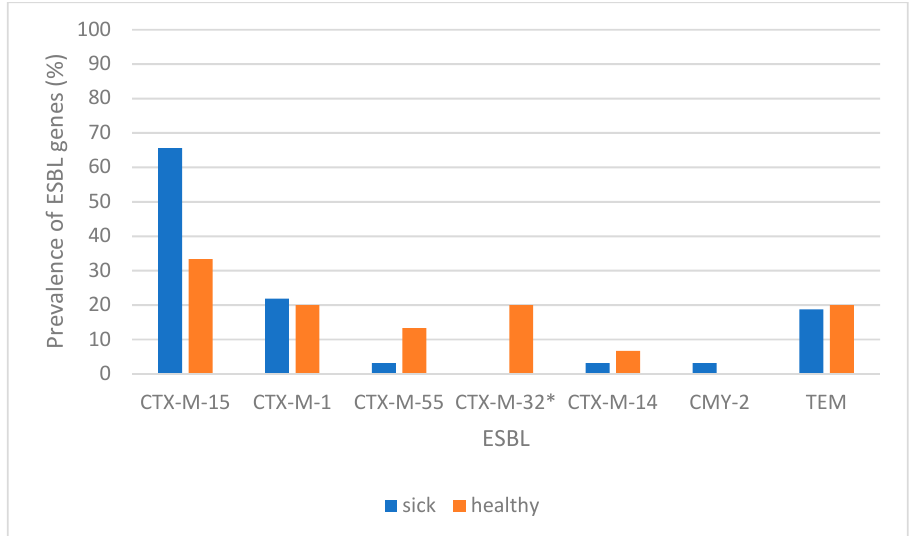
Figure 2. Distribution of ESBL-encoding genes from E. coli isolates in sick and healthy dogs. Gene encoding β -lactamases with p < 0.05 is indicated with (*).